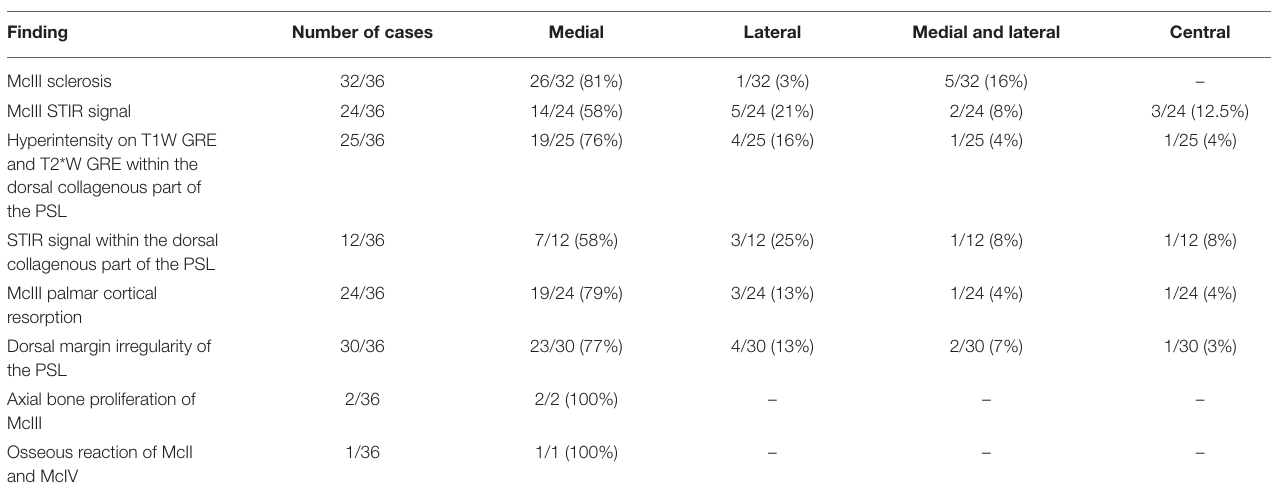
TABLE 3 | Distribution of pathological findings in lame